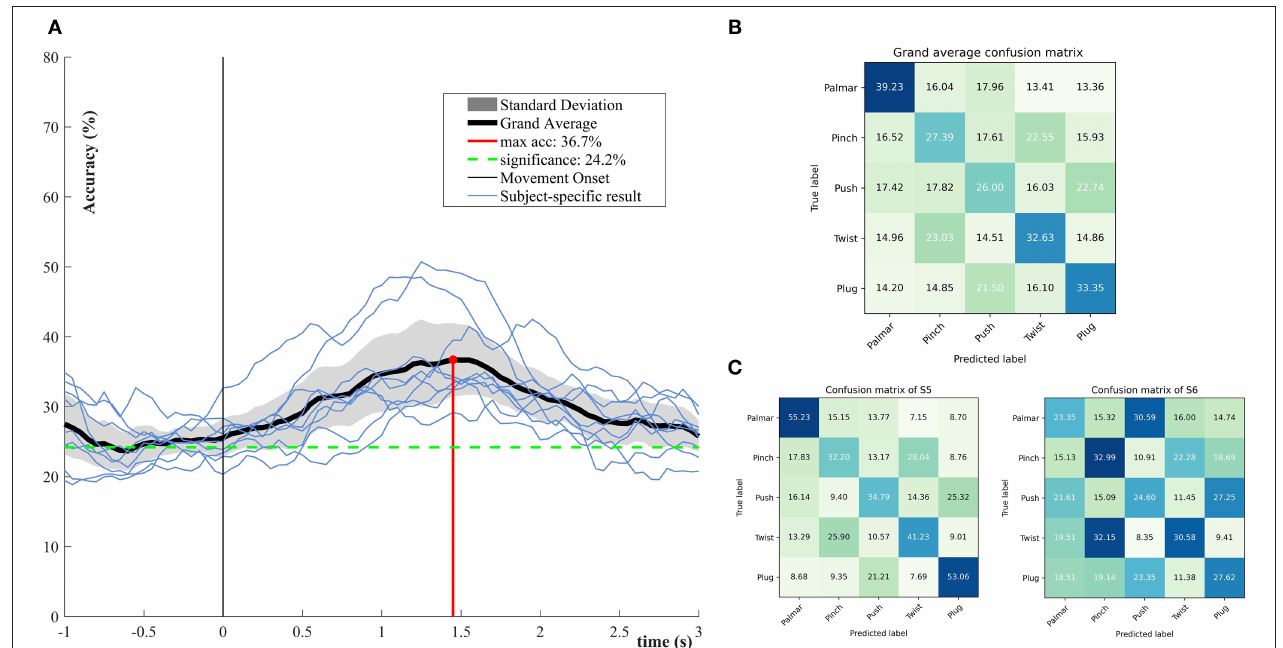
FIGURE 5 | Multiclassification performance over all subjects. (A) The grand average classification accuracies including its confidence interval (alpha = 0.05) and subject-specific classification results. (B) Grand average row-wise normalized confusion matrix at grand average peak performance. (C) Subject-specific row-wise normalized confusion matrix at grand average peak performance, corresponding to the subjects who achieved the highest and lowest performance in (A) .